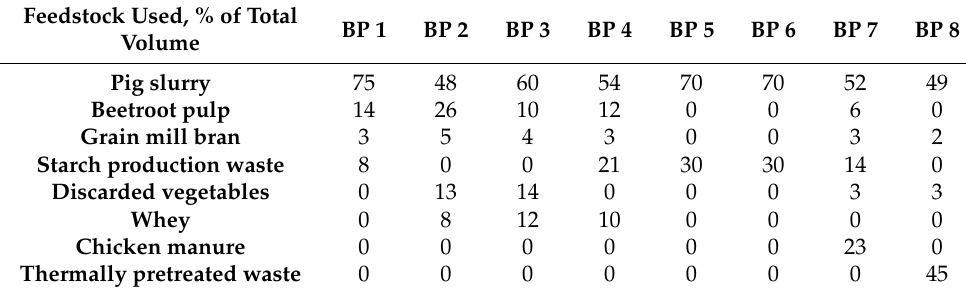
Table 2. Feedstock mix in 8 biogas plants tested during the experiment.